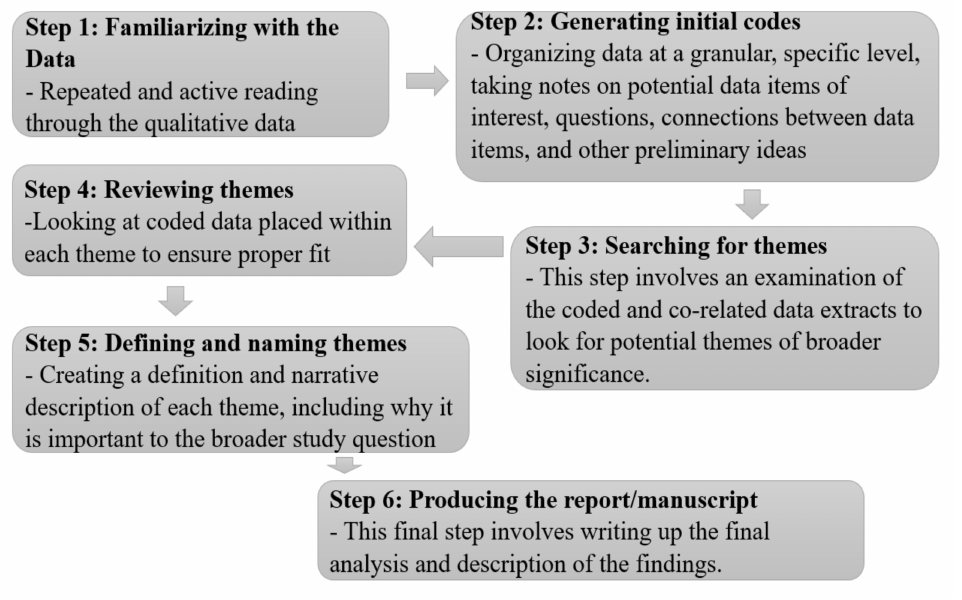
Figure 2. The procedure flow of the TCA that was performed for qualitative